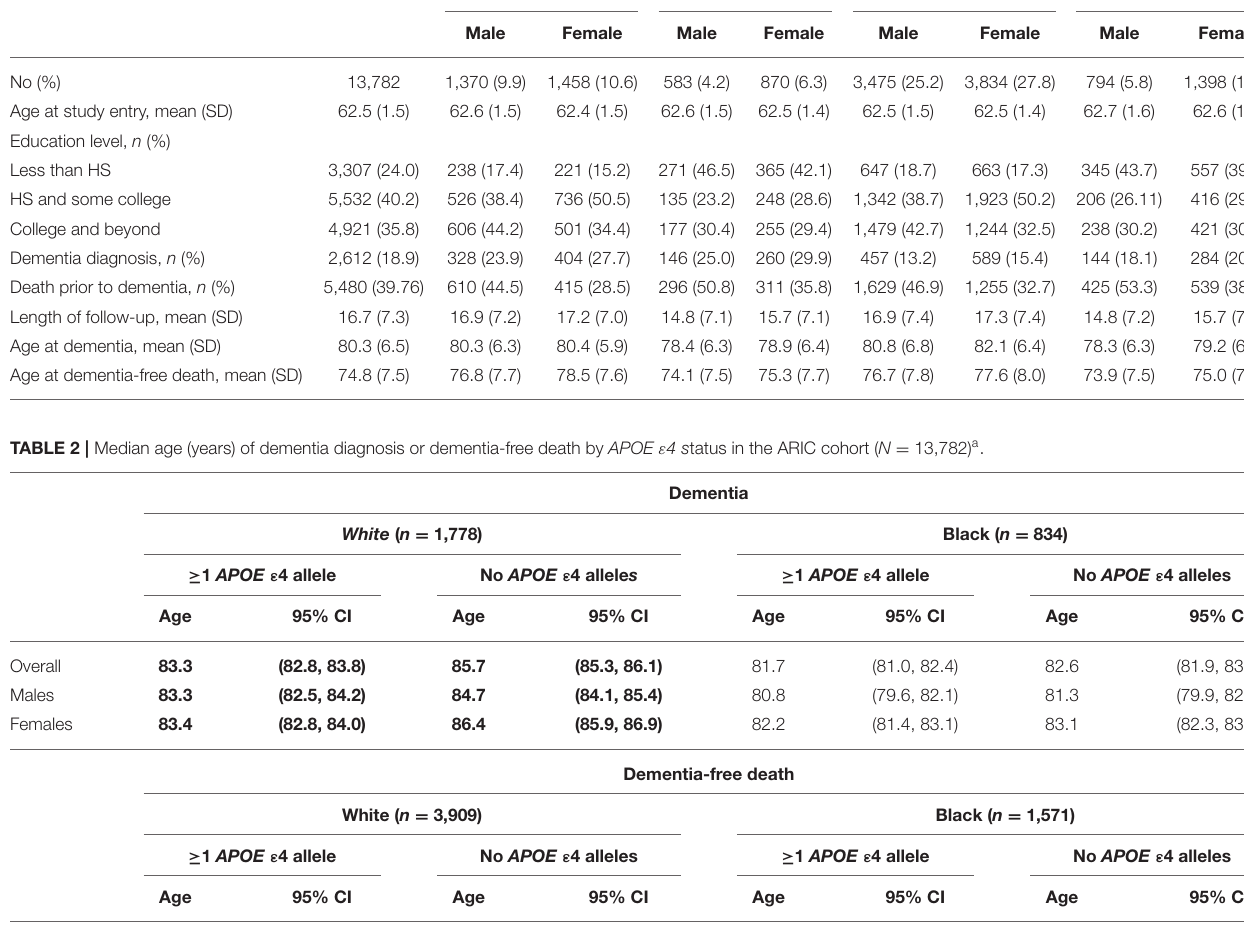
TABLE 1 | Demographic characteristics of study population. ≥ 1 APOE ε 4 allele No APOE ε 4 allele White Black White Black